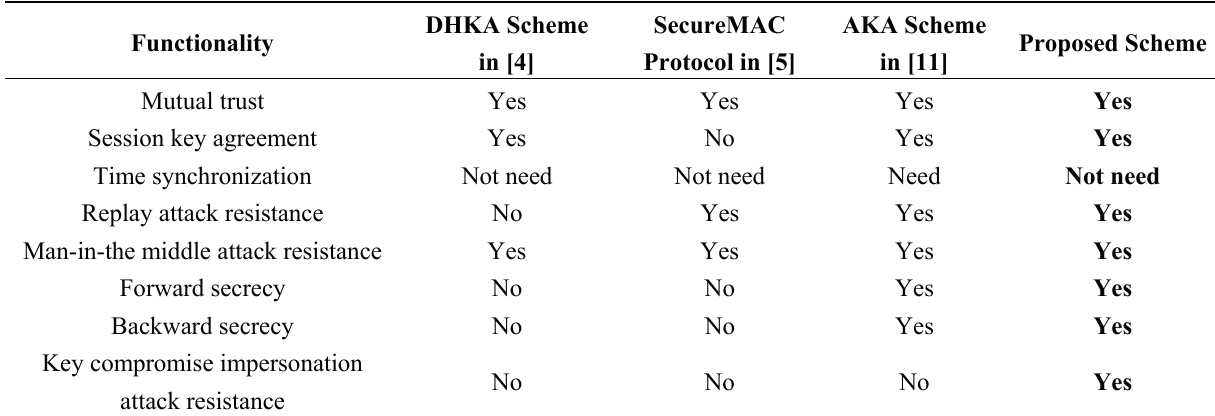
Table 2. The functionality